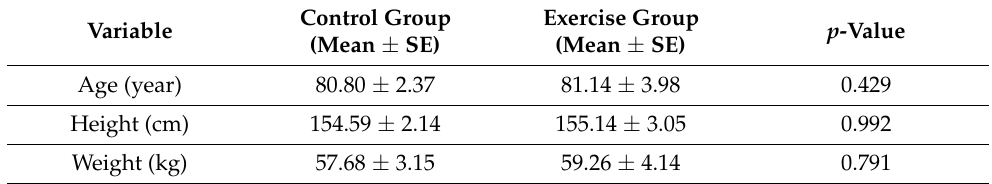
Table 1. Characteristics of the study